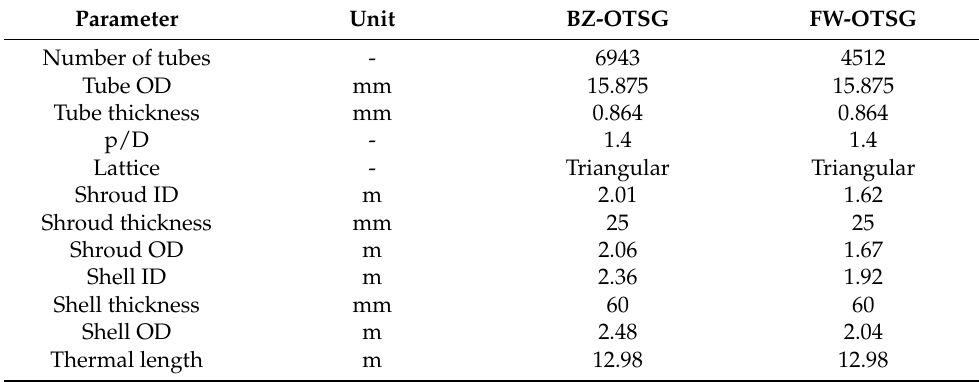
Table 2. BZ and FW OTSG main resulting geometrical